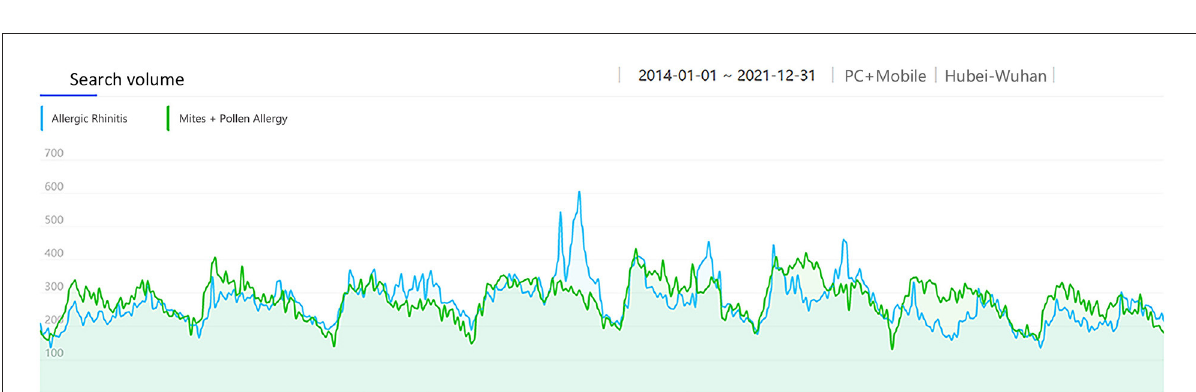
FIGURE10 The search volume of various airborne pollens in Wuhan from 2014 to 2021.